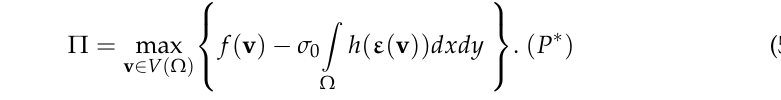
Figure 1. The division (Equation (48)) of the plane of principal strains into subdomains. The function h ( ε ) is continuous, i.e., it is continuously stitched along the lines Tr ε = 1, √ Tr ε = − 1, (cid:107) dev ε (cid:107) = 2 (see Figure 1). Moreover, it is convex, of linear growth outside the central domain D 0 , vanishes at ε = 0 and is non-negative. In conclusion, the problem dual to ( P ) (see Equation (33)) assumes the